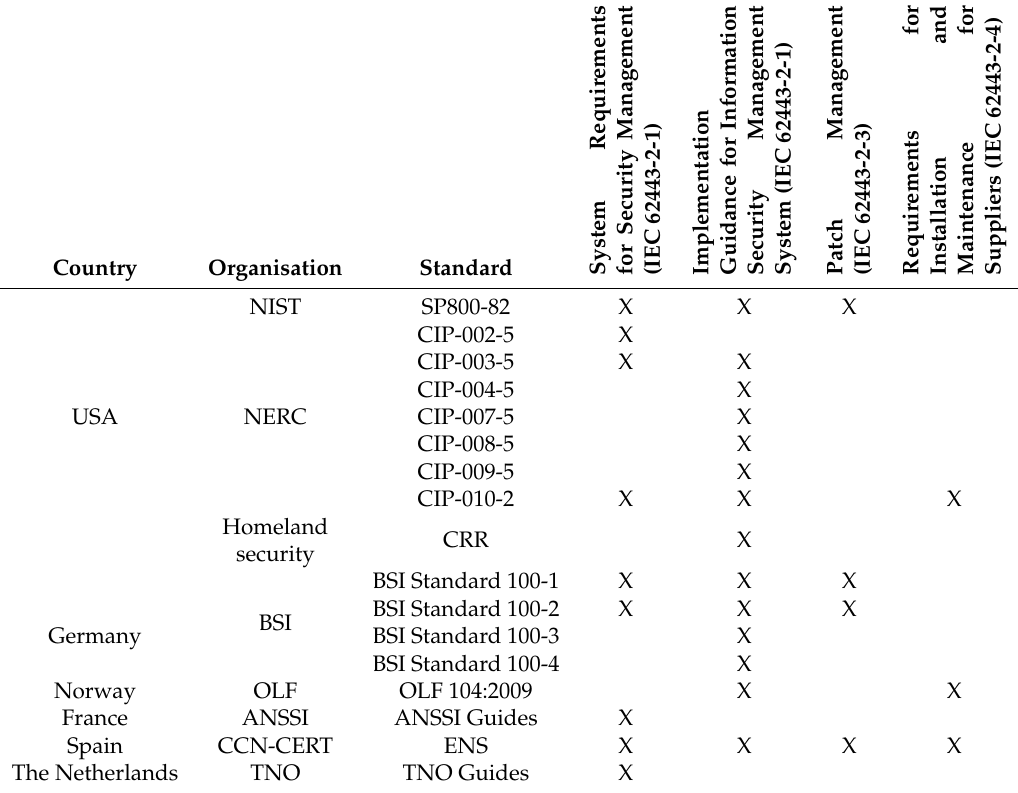
Table 3. Mapping of IEC 62443-2-X contents [35–37] to national standards (USA and Europe).